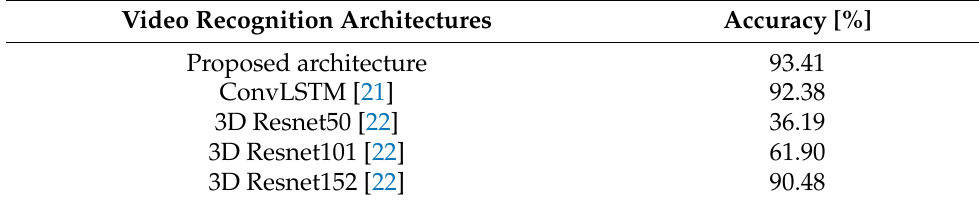
Table 7. Accuracy comparison of the proposed architecture with various neural network architectures using the LoDVP dataset for detecting abnormal activities.